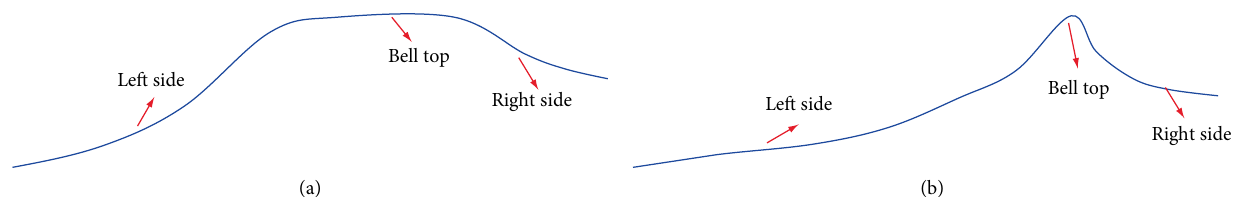
flooding results in tight oil reservoirs. 2